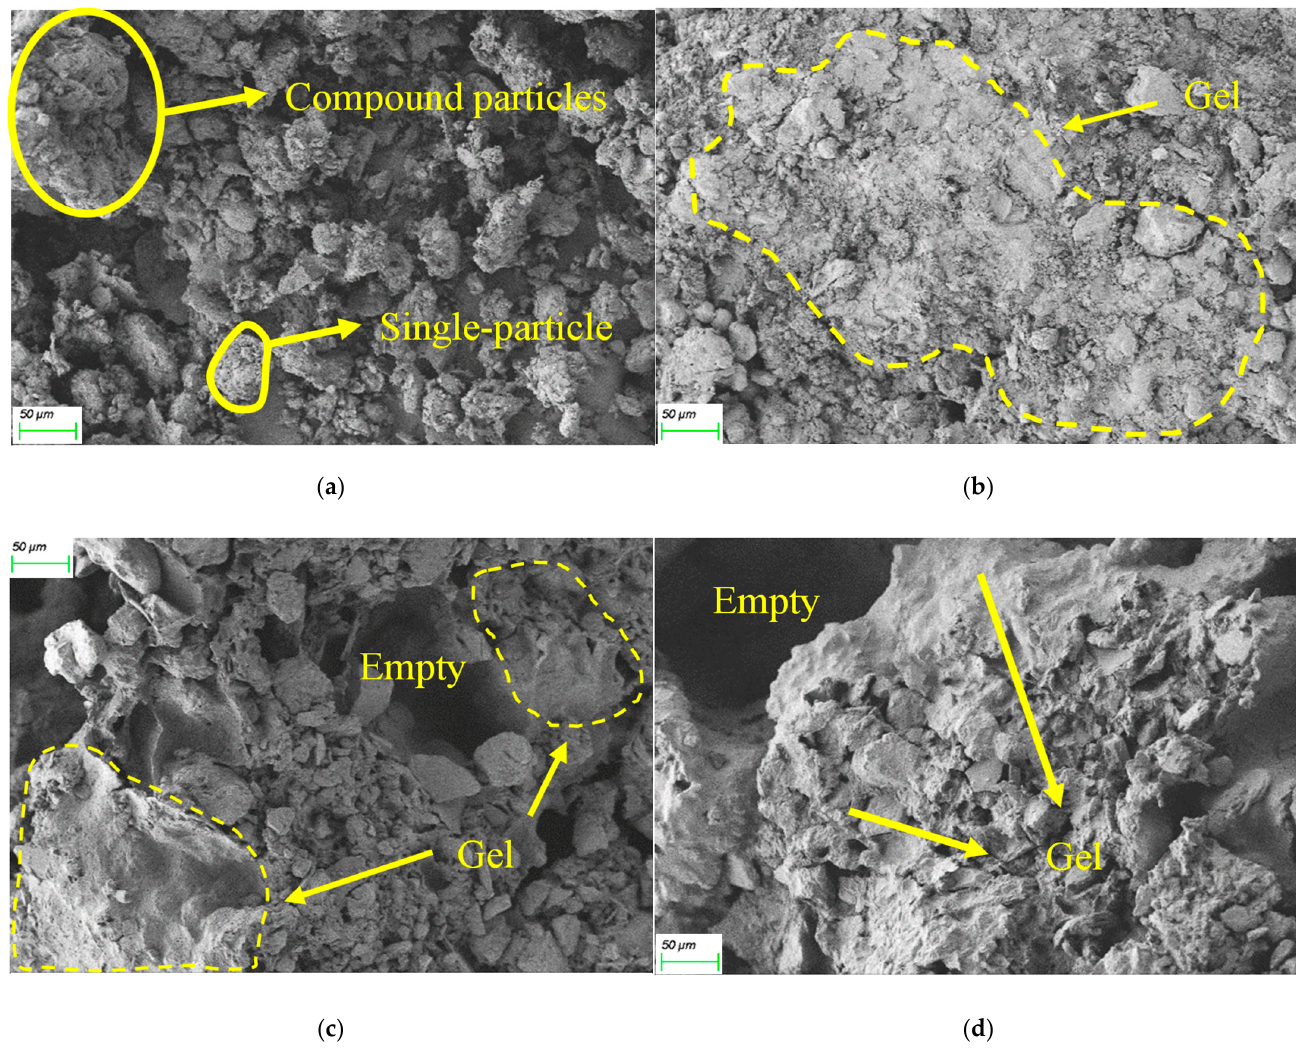
Figure 12. The SEM of UL and SL in different service environments. ( a ) UL, ( b ) SL without soaking, ( c ) SL soaked in water, ( d ) SL soaked in salt